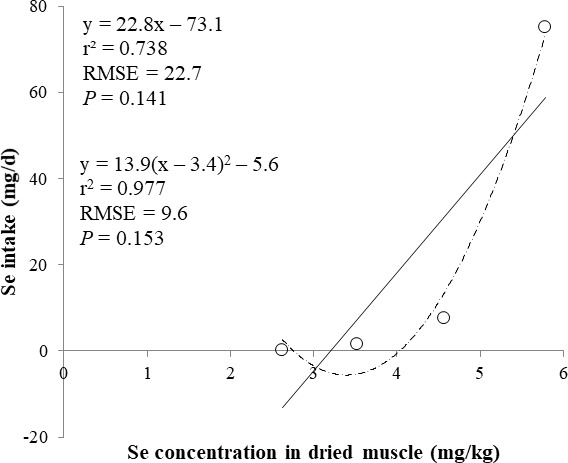
Linear and quadratic regression equations for estimating daily selenium (Se) intake (mg/d) based on the Se concentration in dried muscle (mg/kg).Each data point represents least squares mean of four observations. r2, coefficient of determination; RMSE, root mean square of error.